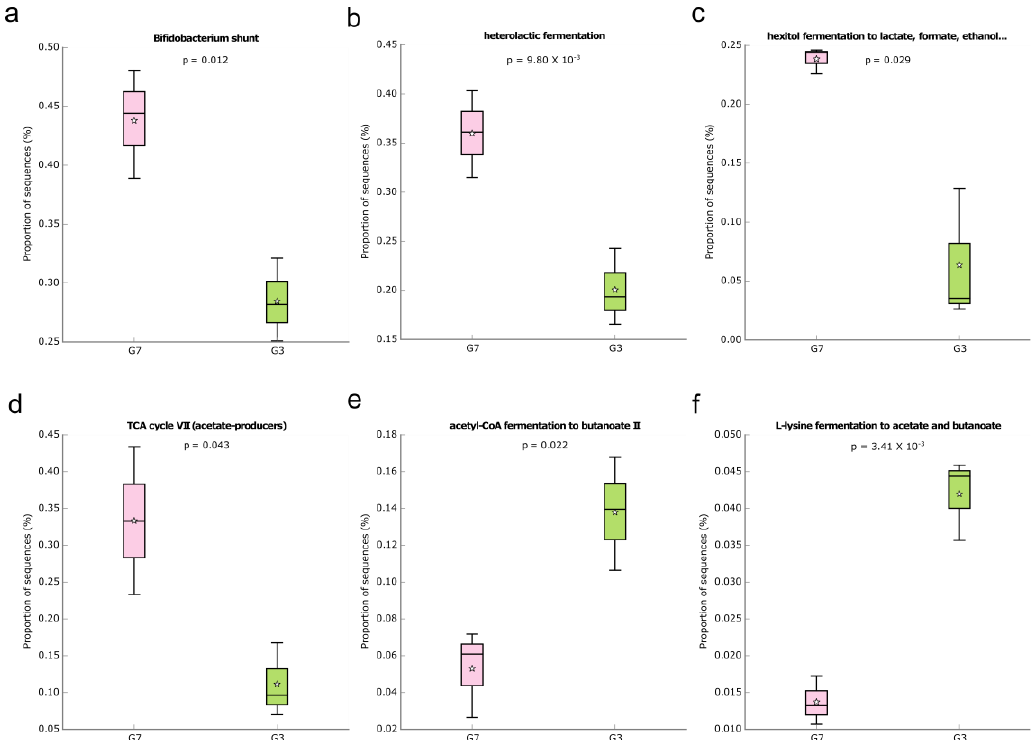
Figure 5. Box plot showing the distribution in the proportion of the predicted MetaCyc pathways related to SCFA ( a – f ) production between the groups G3 and G7. Boxes indicate the IQR (75th to 25th of the data). The median value is shown as a line within the box and the mean value as a star. Whiskers extend to the most extreme value within 1.5*IQR. Where: a: Bifidobacterium shunt; b: Het- erolactic fermentation; c: Hexitol fermentation to lactate, formate, ethanol; d: TCA cycle VII; e: Ace- tyl-CoA fermentation to butanoate II; f: L-lysine fermentation to acetate and butanoate.